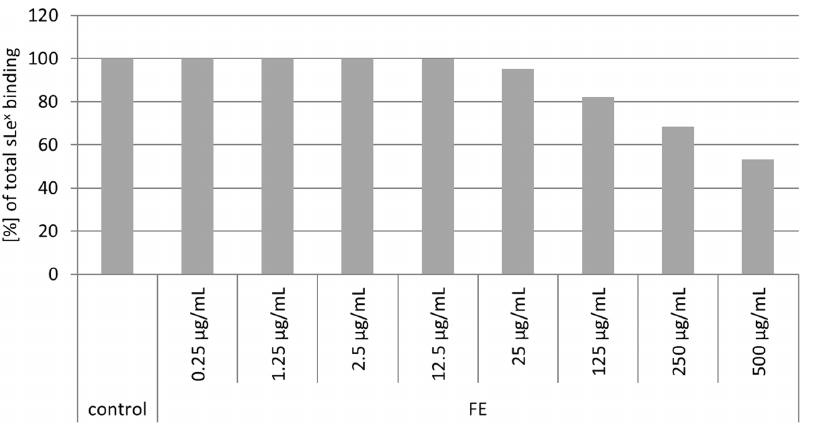
Figure 5. Influence of Okra FE on H.pylori strain 17875 babA1A2 binding to sialyl-Le x -HSA. Data are related to the control (only 17875 babA1A2 with sLe x -HAS = 100%).